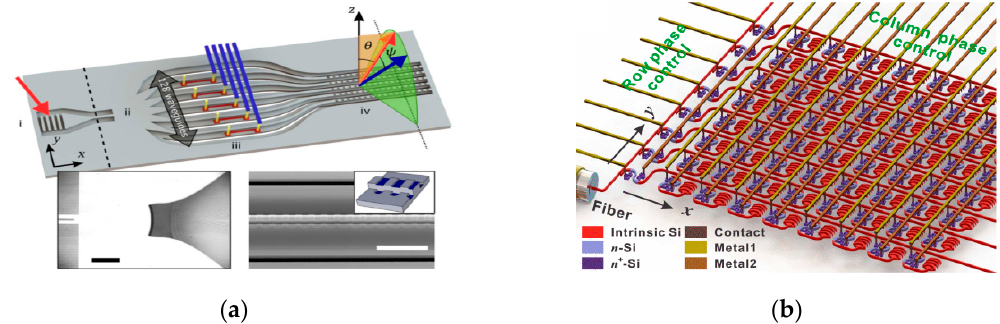
Figure 6. A typical example of antennae arrangement of ( a ) a 1D OPA (adapted with permission from [65] © The Optical Society) and ( b ) a 2D OPA (© 2019 IEEE. Reprinted, with permission, from [54]).